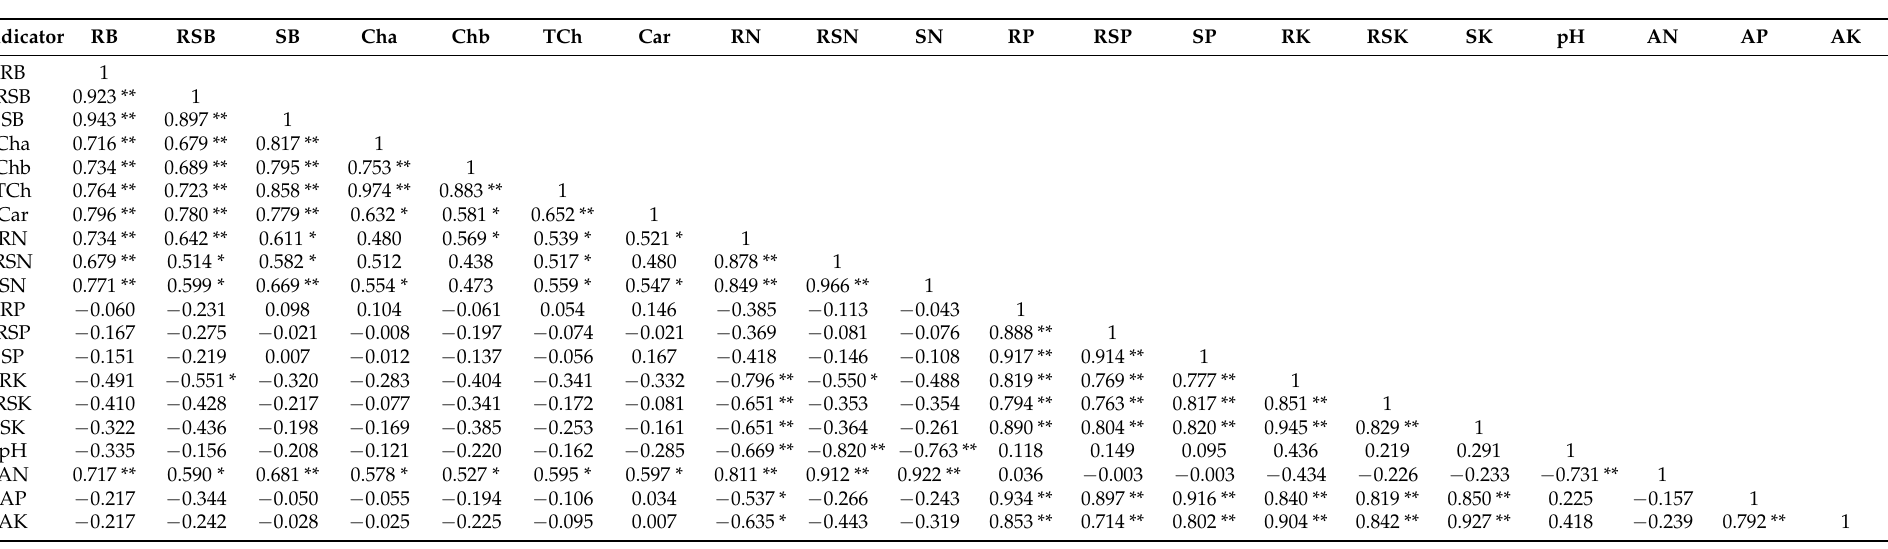
Table 3. Correlations among the different